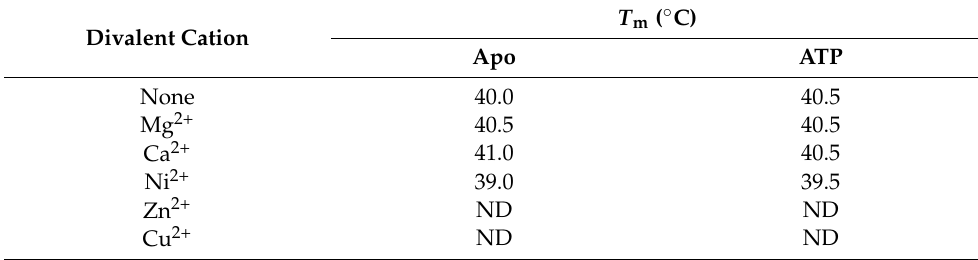
Table 3. Showing the melting temperature ( T m ) for KpNNAT in the absence and presence of ATP and varying divalent cations metal.